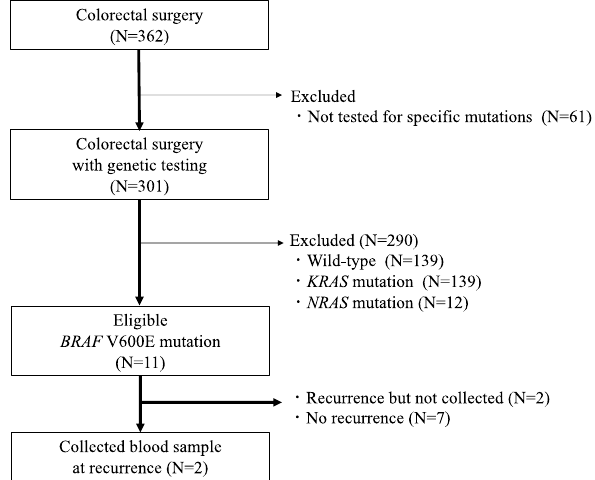
Figure 1. Flow chart presenting BRAF V600E mutation detection in the study. N number of